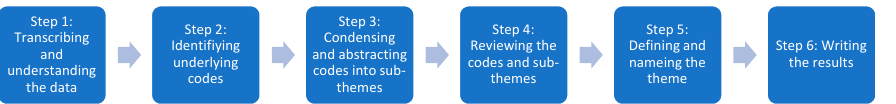
Figure 1. An illustration of the thematic analysis steps in this study (following Braun and Clark [39]).